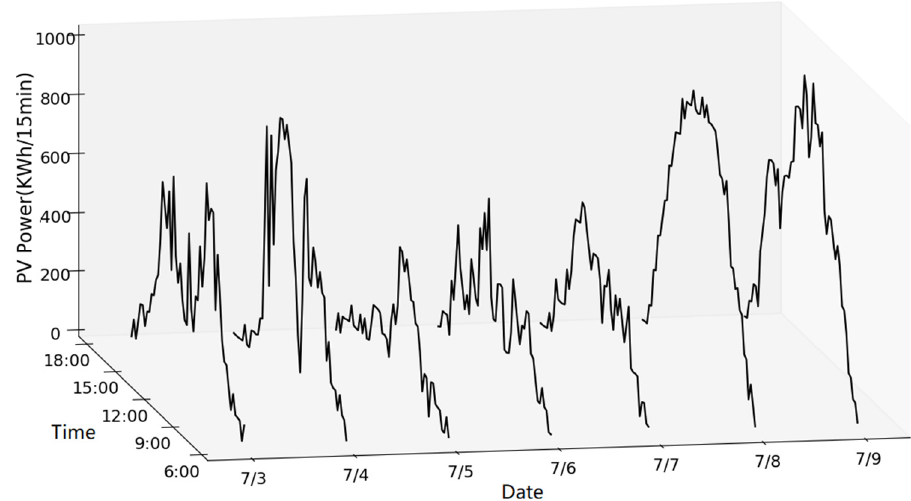
Figure 3. Day-curves of PV power from partial data.